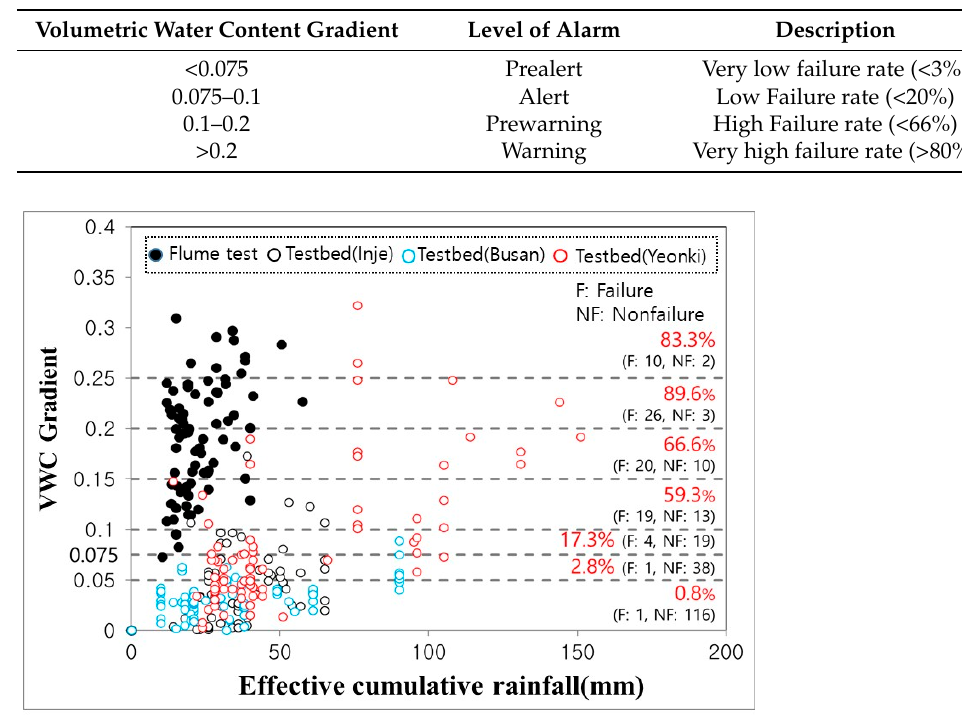
Table 4. The early warning criteria using the VWC gradient.